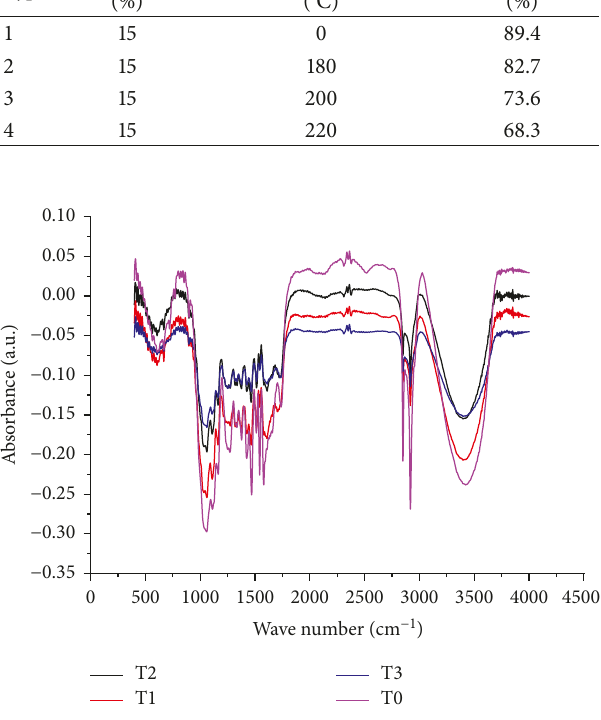
Figure 5: The FTIR spectra of the specimens with initial 15% MC, at various temperatures, and then infested by the white rot for 4 weeks: (T0) untreated, (T1) 220 ° C, (T2) 200 ° C, and (T3) 180 ° C.